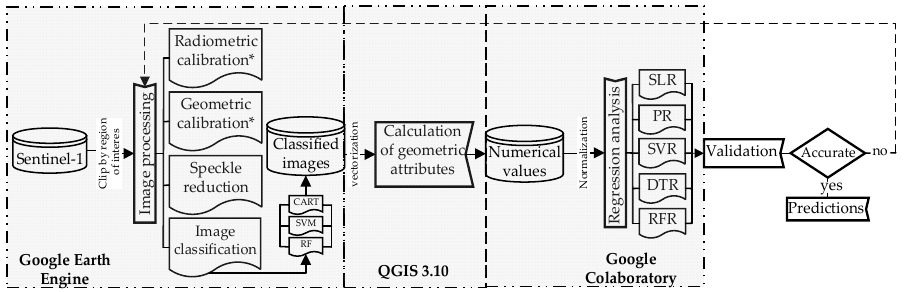
Figure 2. Methodological design for analysing the dynamics of the water surface of Burlan and Pomacochas Lakes during 2014–2020 using SAR images. * This procedure was performed internally by GEE.